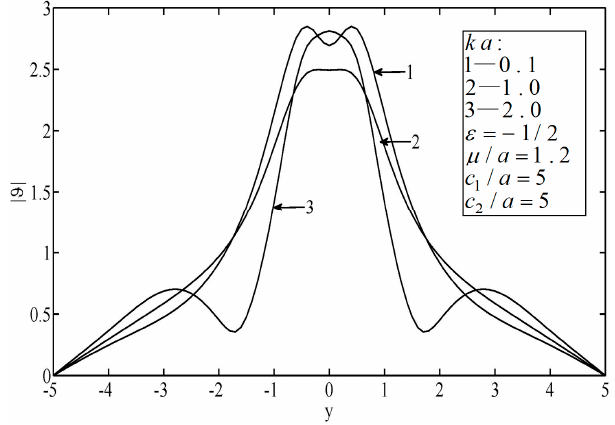
Figure 2. Temperature on the surfaces of the block.